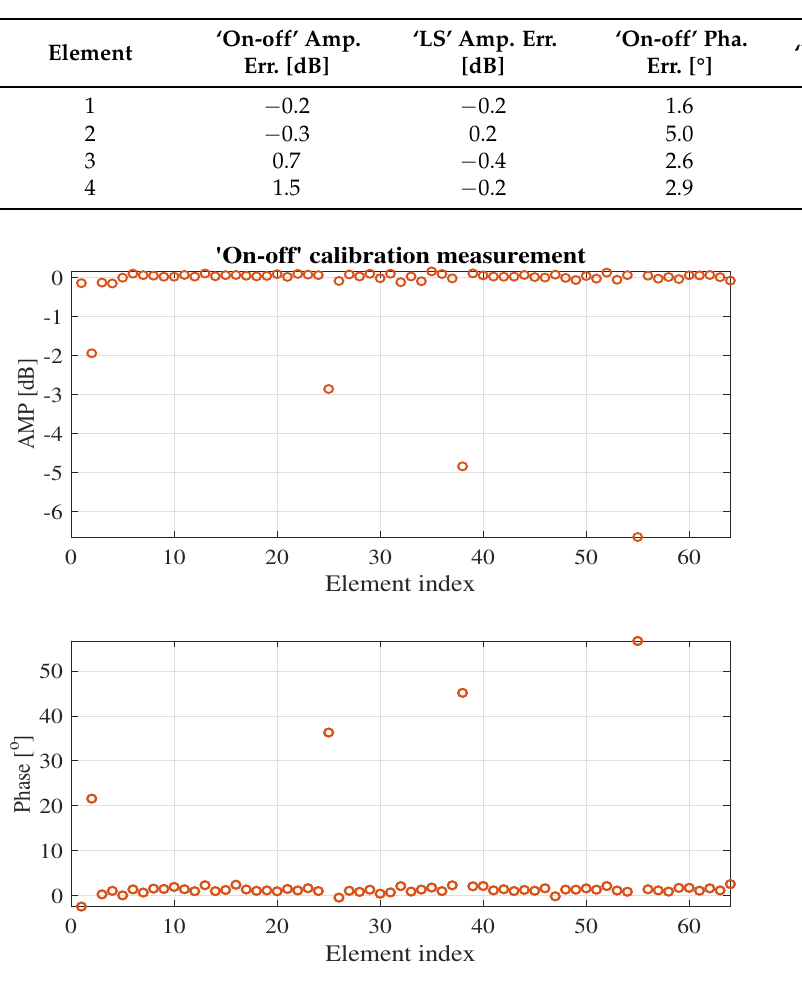
Figure 10. ‘On-off’ calibration effectiveness measurement